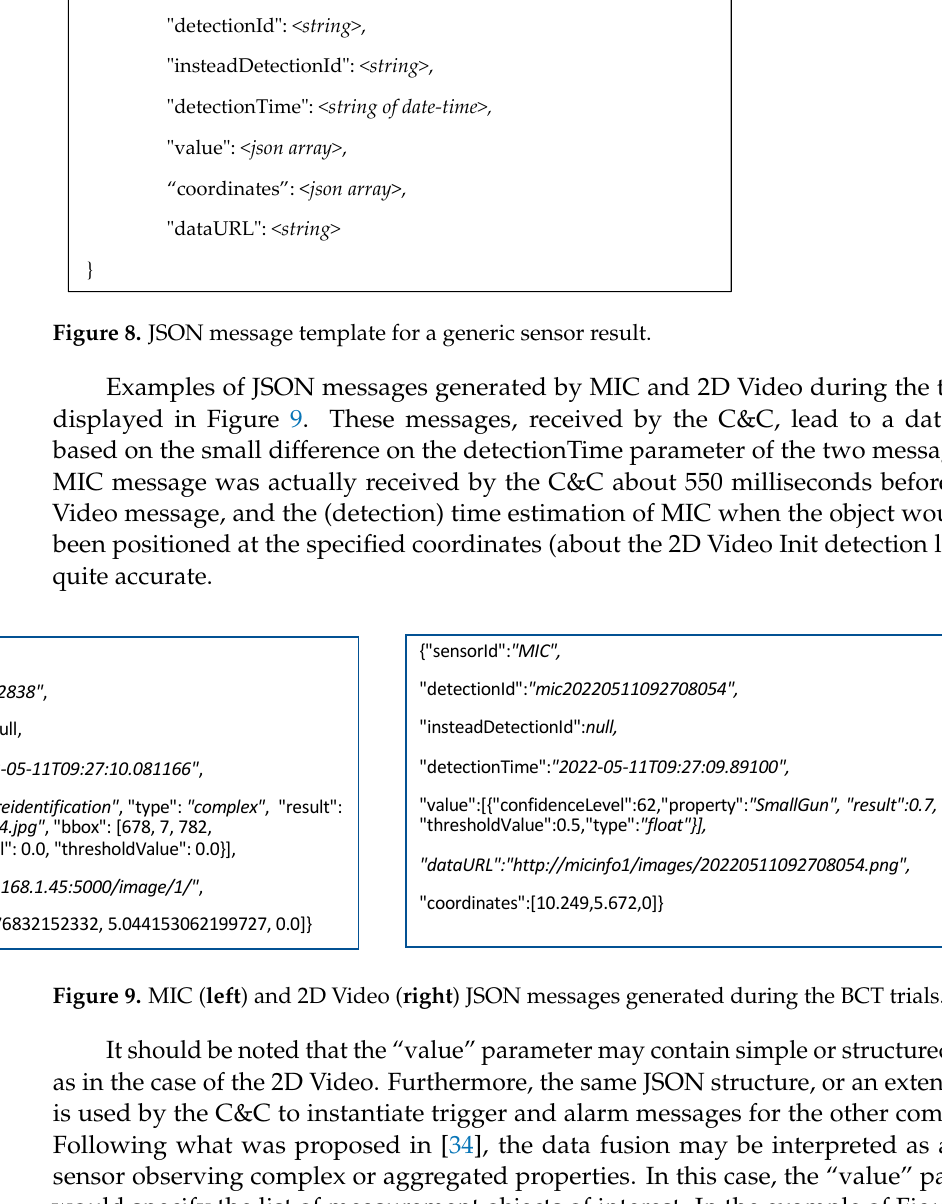
Figure 9. MIC ( left ) and 2D Video ( right ) JSON messages generated during the BCT trials.